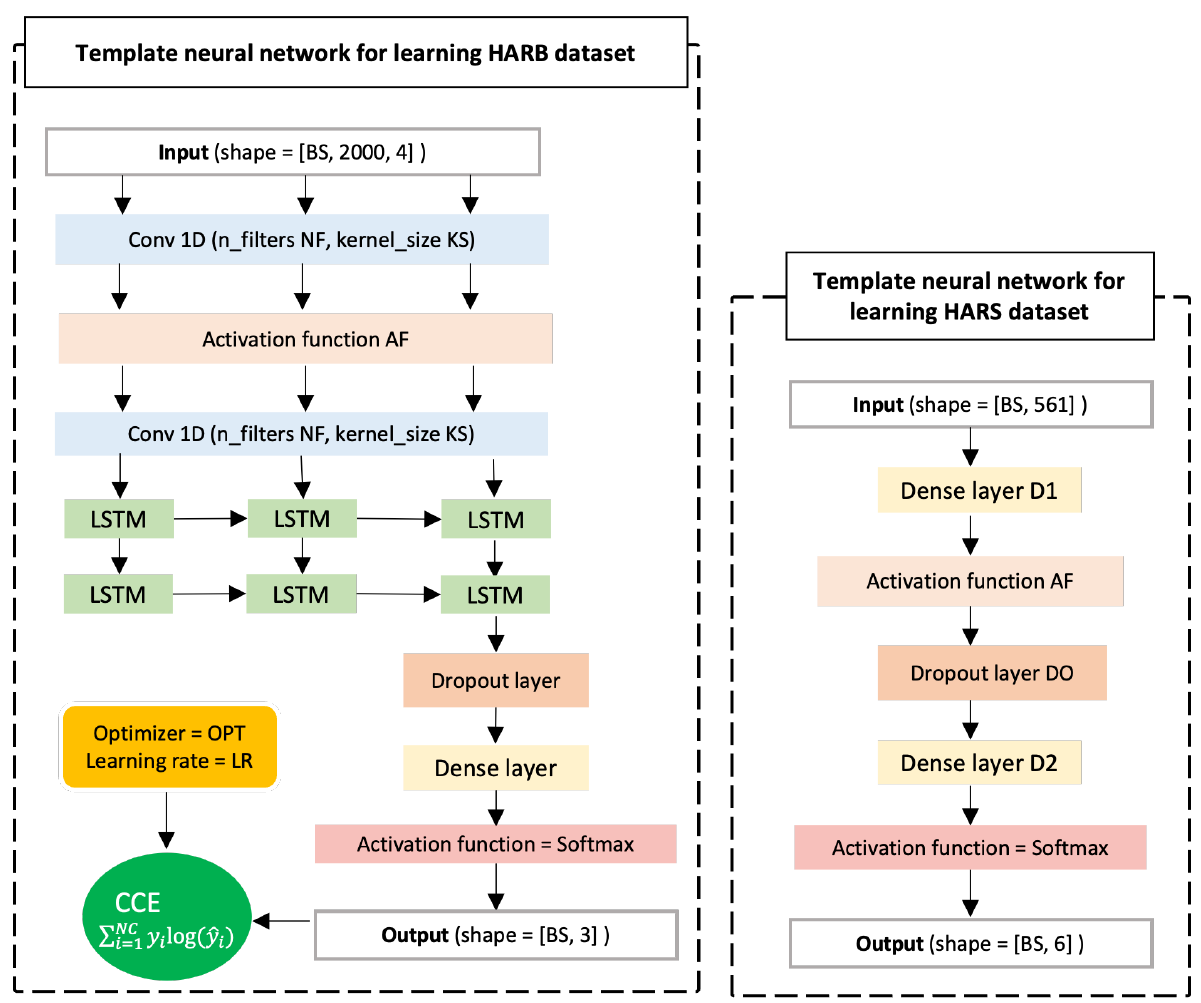
Figure 2. ( Left ) A template deep learning model used to derive heterogeneous models with various learning capacities for learning the HARB dataset in both centralized and federated learning settings; ( Right ) A template deep learning model is used to derive variant models to train on the HARS dataset in centralized and federated